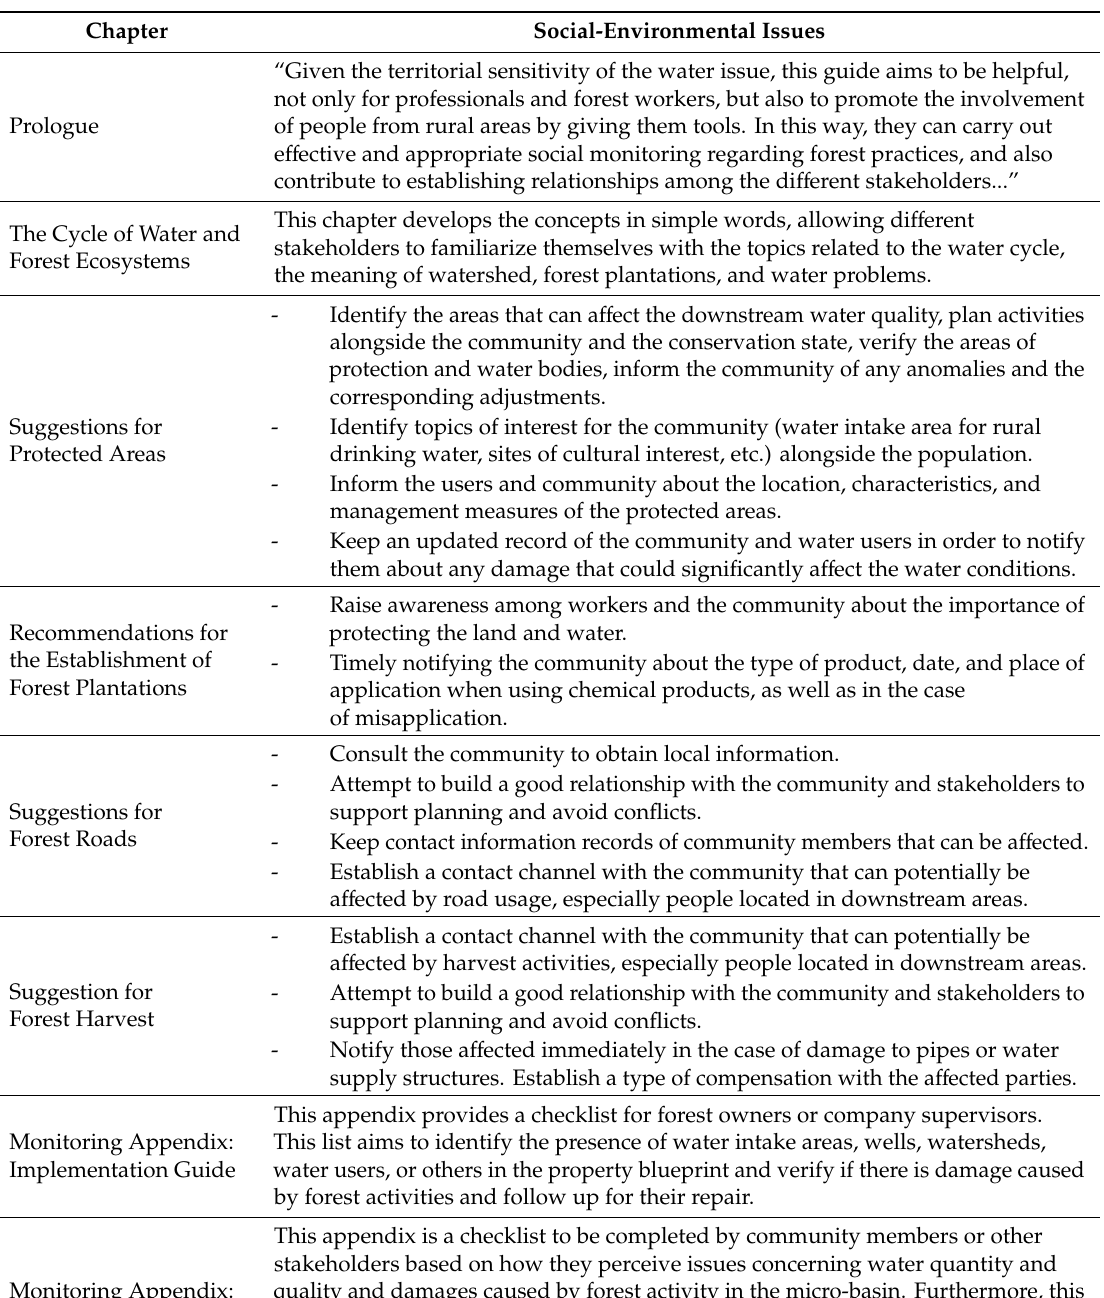
Table 2. Summary of social aspects incorporated into the